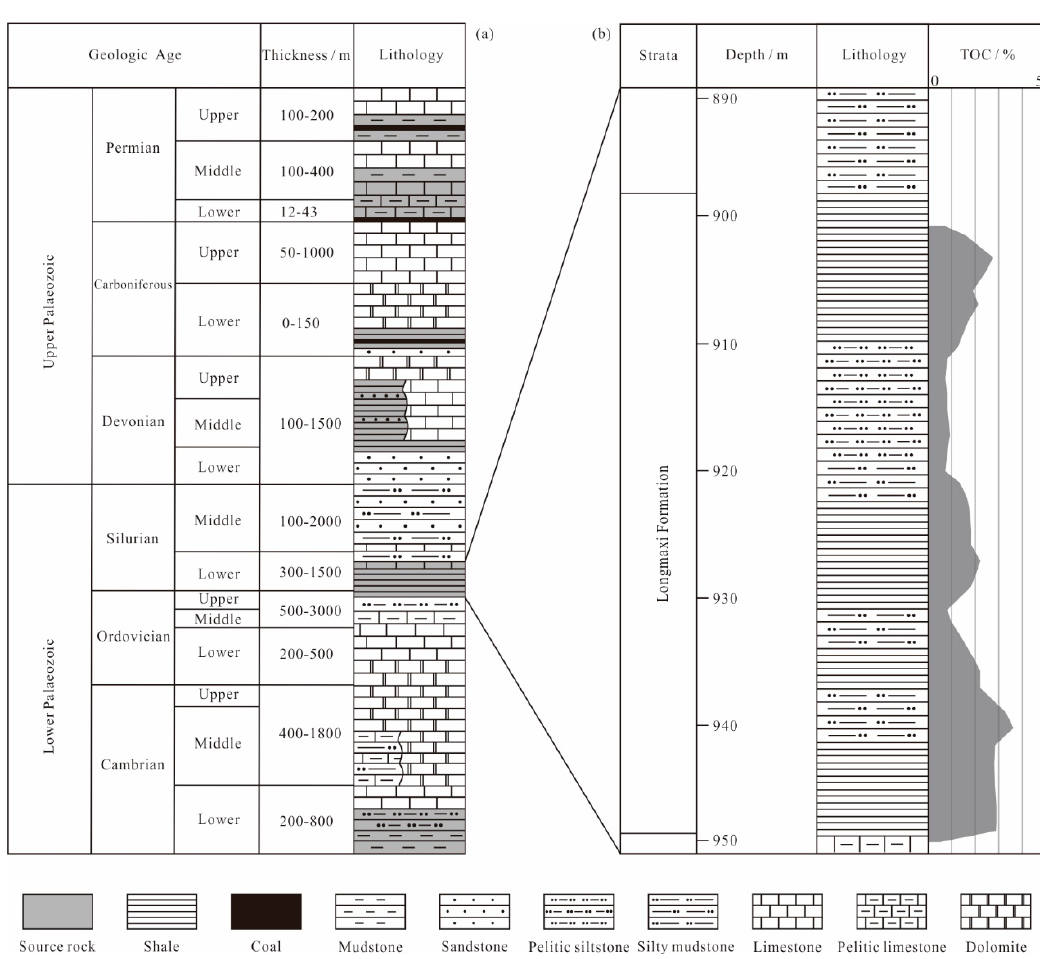
Figure 2. Synthetical stratum histogram of the research area. ( a ) The simplified stratigraphic column and the location of several high-quality source rocks of South China during the Paleozoic period (modified after [12,51]). ( b ) The lithological column and the change curve of measured total organic carbon (TOC) values of the Longmaxi Formation in Well LD1 (modified after [54]).